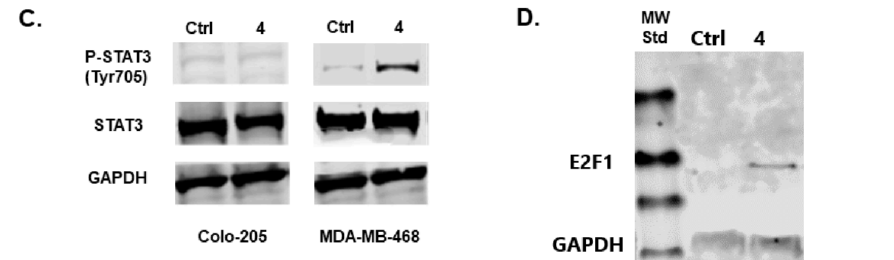
Figure 2. ( A ) E ff ect of treatment with 10 µ M inhibitor 4 (72 h) on cell viability of MDA-MB-468 (MDA), Colo205 (Colo) and HCT116 (HCT) cells compared to vehicle-treated control (Ctrl) cells. ( B ) E ff ect of treatment with 10 µ M inhibitor 4 (48 h) on apoptosis of MDA-MB-468 (MDA) and Colo205 (Colo) cells compared to vehicle-treated control (Ctrl) cells. ( C ) E ff ect of treatment with 10 µ M inhibitor 4 (24 h) on STAT3 phosphorylation status in MDA-MB-468 (MDA) and Colo205 (Colo) cells compared to vehicle treatment. ( D ) E ff ect of treatment with 10 µ M inhibitor 4 (24 h) on E2F1 protein expression in MDA-MB-468 cells compared to vehicle-treated control (Ctrl). *** p < 0.001 (very